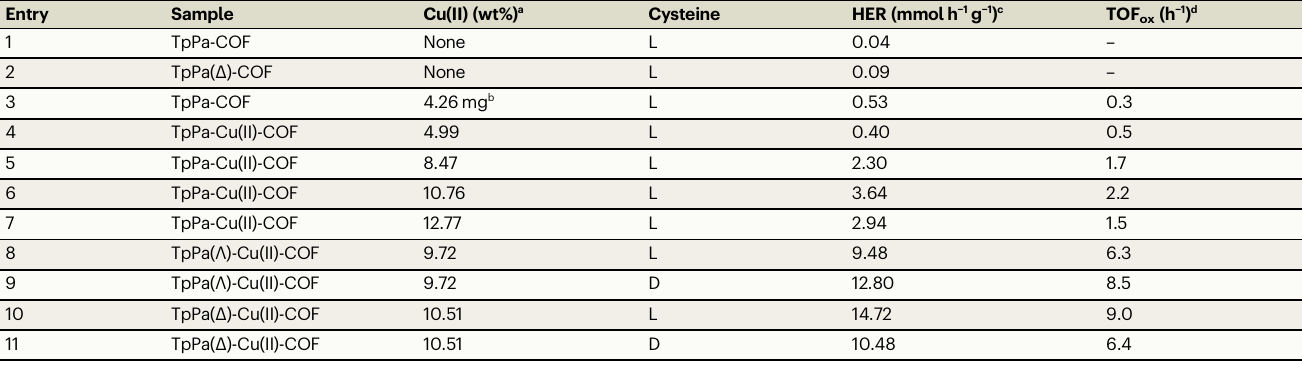
Table 1 | Comparison of hydrogen evolution rate (HER) and sacri fi cial oxidation turnover frequency (TOF ox ) for the different combinations of COFs and